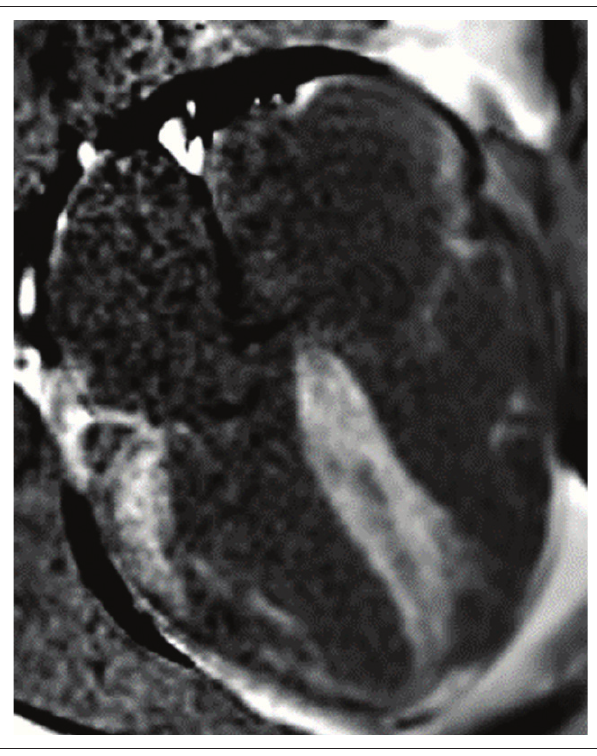
FIGURE 9: Four-chamber LGE sequence in cardiac amyloid. The gadolinium kinetics are abnormal. Blood pool nulls before myocardium (which appears bright).